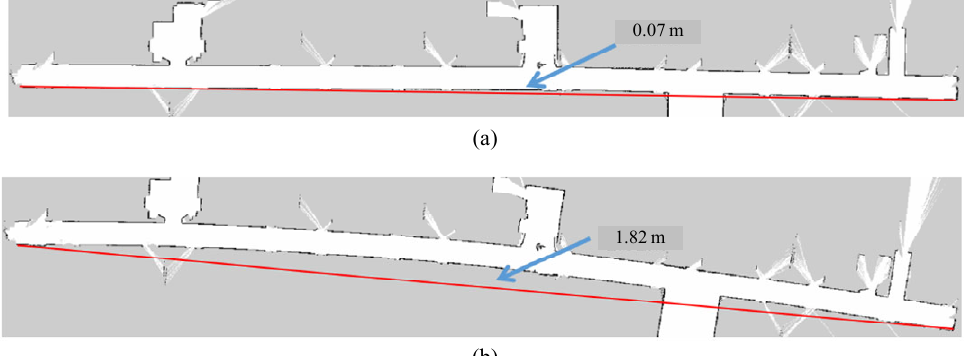
Fig. 12 Front-end map: (a) map built by cartographer and (b) map built by proposed method.